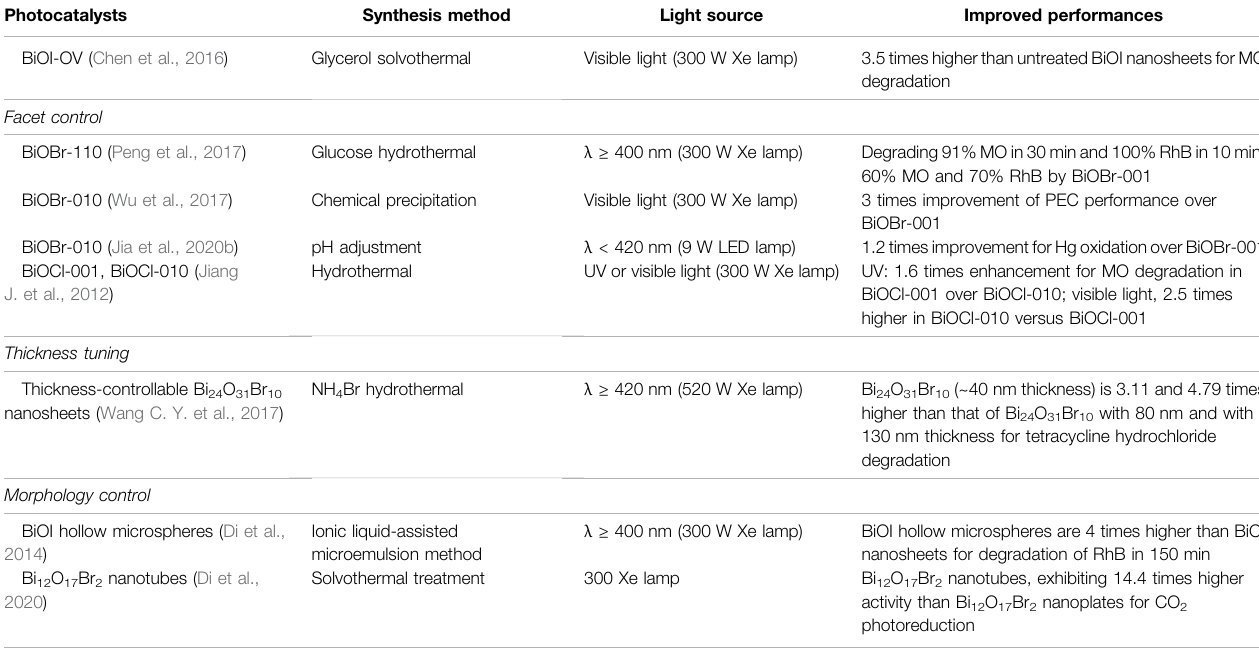
TABLE 1 | ( Continued ) Summary of BiOX-based composites with improved photocatalytic